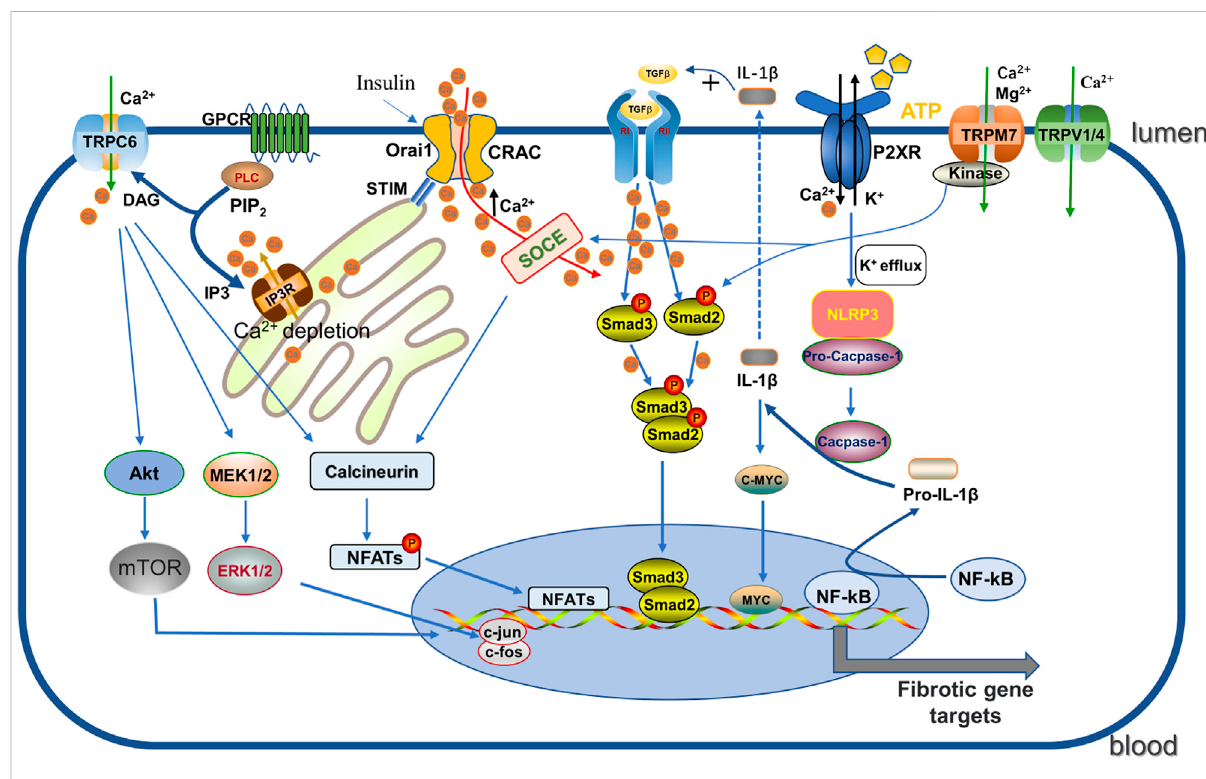
FIGURE 2 Regulation of CRAC, P2XR, TRP channels. (1) GPCR activates PLC, then further decompose the phosphorylated PIP2 into DAG and IP3. IP3 acts onIP3RontheER,triggeringCa 2+ releaseleadingtodepletion,whichissensedbySTIMandthenbindsandactivatestheORAIpore-formingchannel CRAC, facilitating Ca 2+ entry. Enhanced Ca 2+ promotes the phosphorylation of Smad2/3 to enhance the TGF- β 1 signaling pathway, and binds to calcineurin and promotes NFAT activity. (2) Activated P2X7R induces NLRP3 in fl ammasome activation by K + ef fl ux and catalyzes pro-IL -1 β cleavage to IL-1 β , which not only promotes the TGF signaling pathway but also enhances c-myc transcriptional enhancement of fi brosis. (3) TRPC6 promotes the fi brotic process byenhancing AKT-mTOR and ERK1/2pathwaysas well as thecalcineurin/NFAT pathway.DAG:diacylglycerol; GPCR: G protein coupled receptor; IP3: 1, 4, 5-triphosphoinositol; IP3R: inositol 1,4,5-triphate receptor; PIP2: phosphorylated phosphatidylinositol 4, 5-diphosphate; PLC: phospholipase C; NFATs: nuclear factor of activated T cells; IL-1 β : Interleukin-1 β ; NLRP3: nucleotide-binding oligomerization domain-like receptor family pyrin